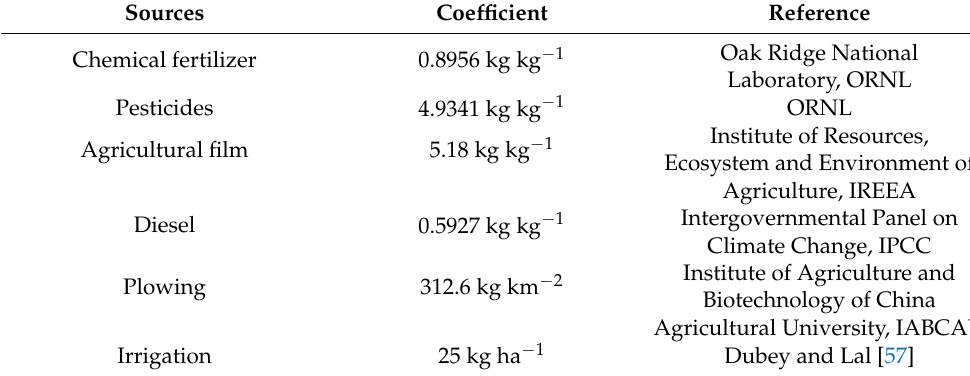
Table 1. Main sources and coefficient of carbon emission in agricultural production.